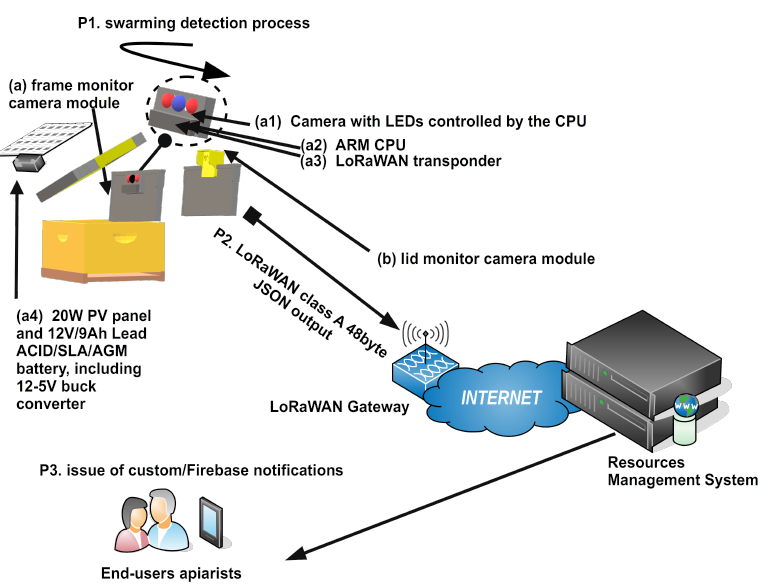
Figure 2. Beehive monitoring end node Version 2 device that includes a LoRaWAN transponder and beehive-monitoring system logic using v2 end node